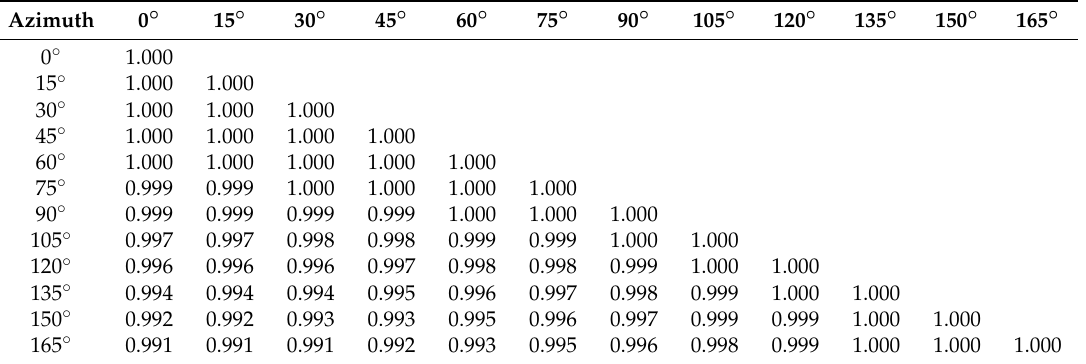
Table 3. The correlation between zenithal-average spectral radiances and different azimuth angles.